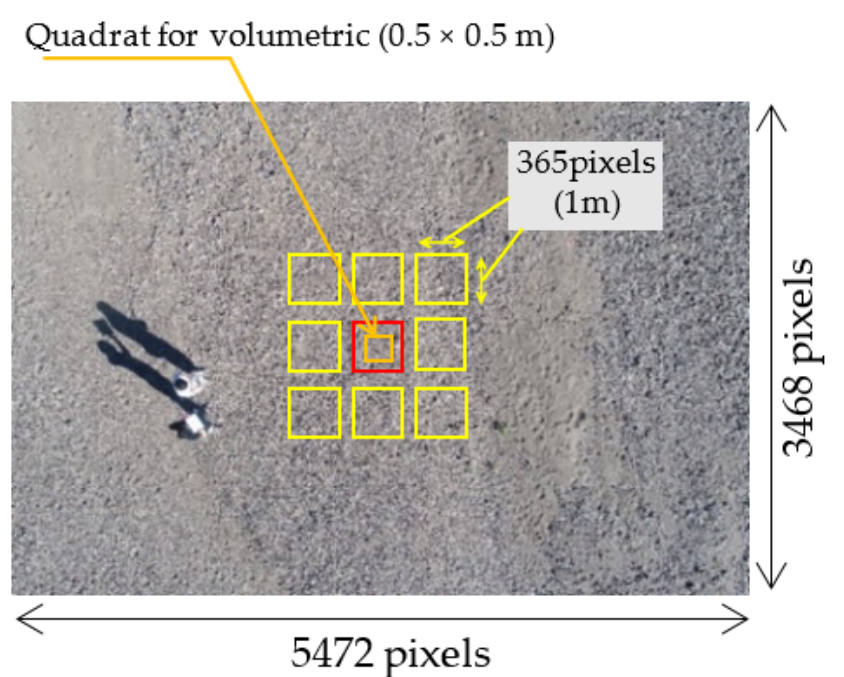
Figure 3. Image preprocessing and how to increase the image data. (Red: volumetric method and BASEGRAIN; Yellow: BASEGRAIN only).